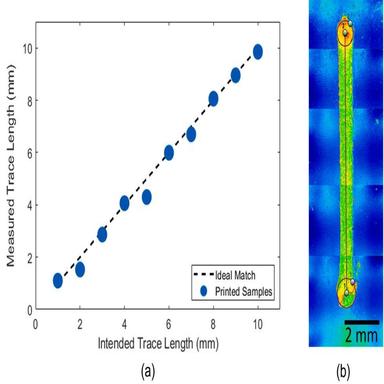
(a) The measured lengths of printed beads plotted against the intended distance set by the Gcode along with (b) a representative optical profilometry measurement of a nominally 10 mm long printed bead.